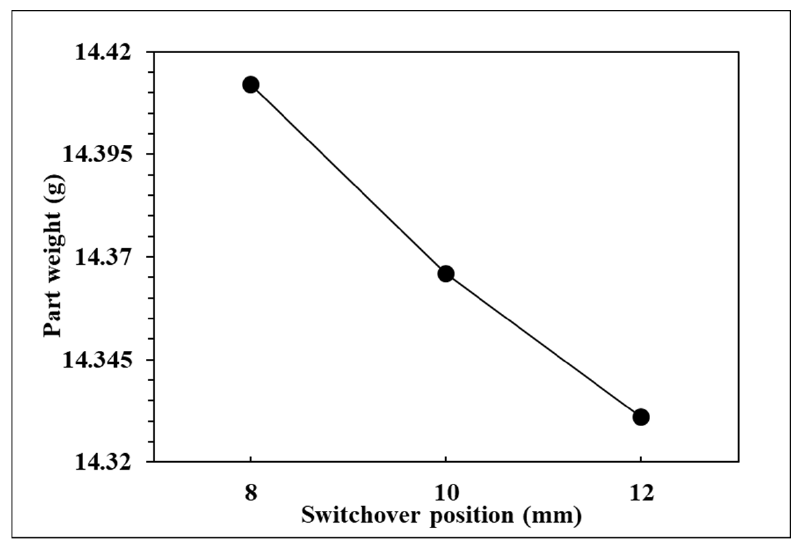
Figure 12. Relationship between part weight and switchover position.